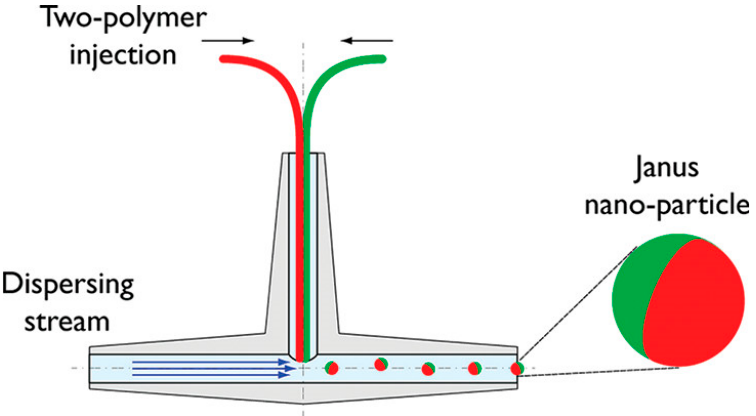
Figure 8. Schematic of the one-step fluidic nanoprecipitation system to fabricate Janus particles. Reproduced with permission from [64], © American Chemical Society, 2012.